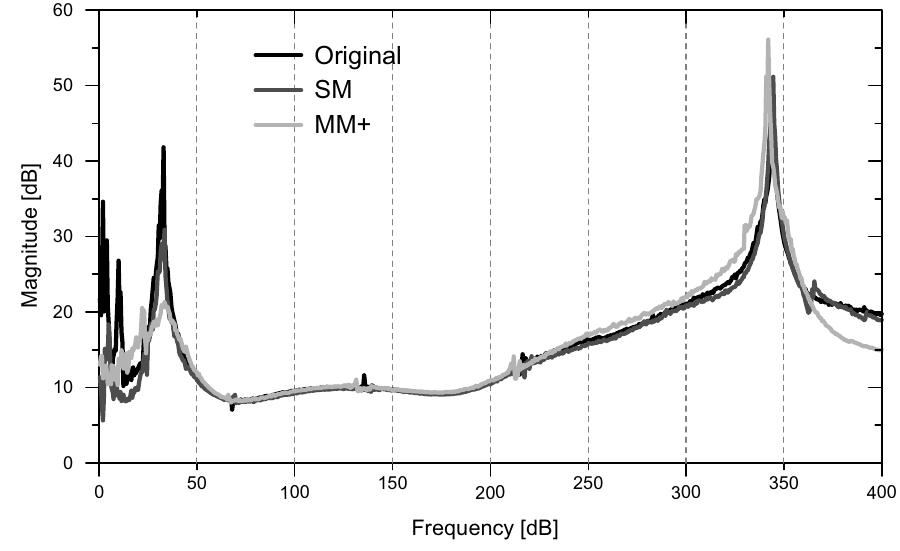
Fig. 7. Transmissibility Indicator (TI) for the three case studies, original structure and modified structures SM and